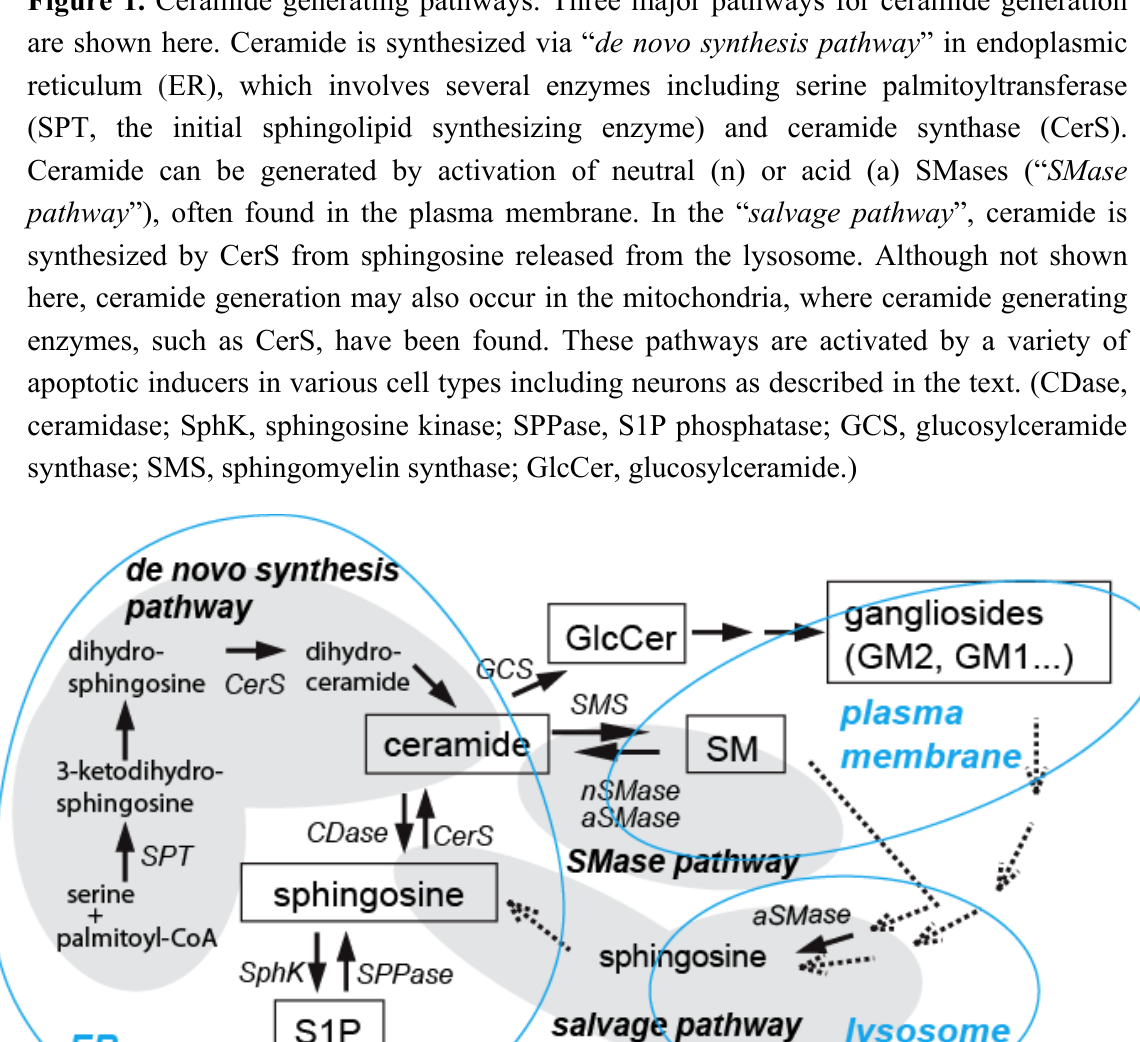
Figure 1. Ceramide generating pathways. Three major pathways for ceramide